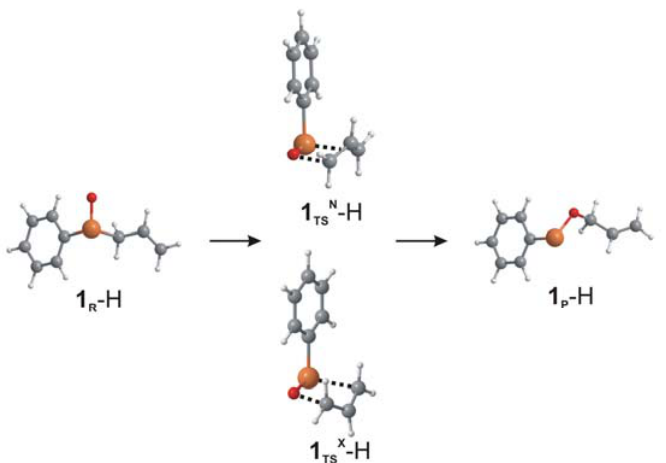
Figure 3. Optimized structures for the selenoxide, endo and exo transition states and product selenenate for 1